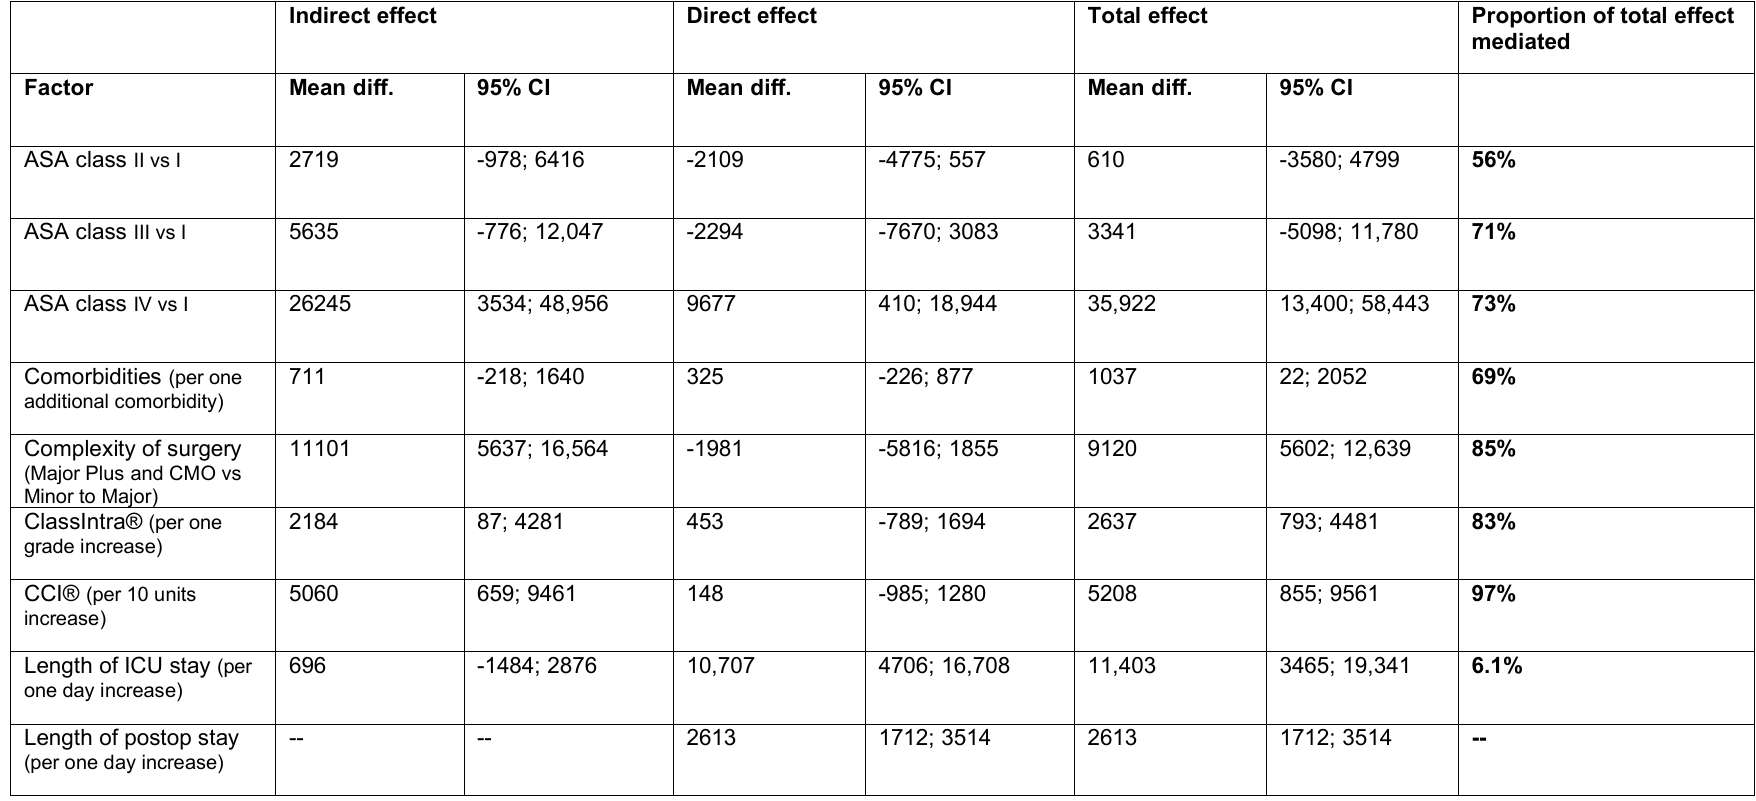
Table 12: Main cost model excluding semi-privately and privately insured patients (in Euros) Coefficients are mean differences in cost; patients with a protracted hospital or ICU stay, recurrent, semi-privately and privately insured patients and patients who died during hospital stay were excluded. R-squared 53.7%